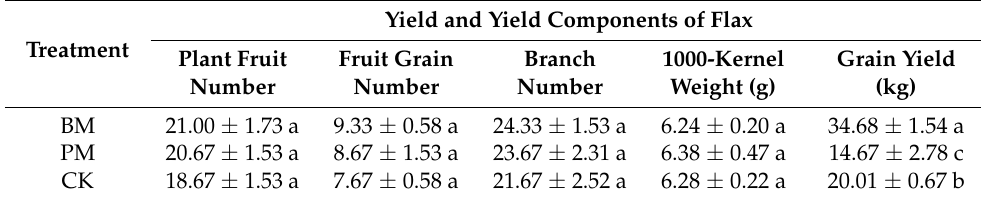
Table 4. Correlation between flax grain yield and covering materials in five growth stages. Yield and Yield Components of Flax Treatment Plant Fruit Fruit